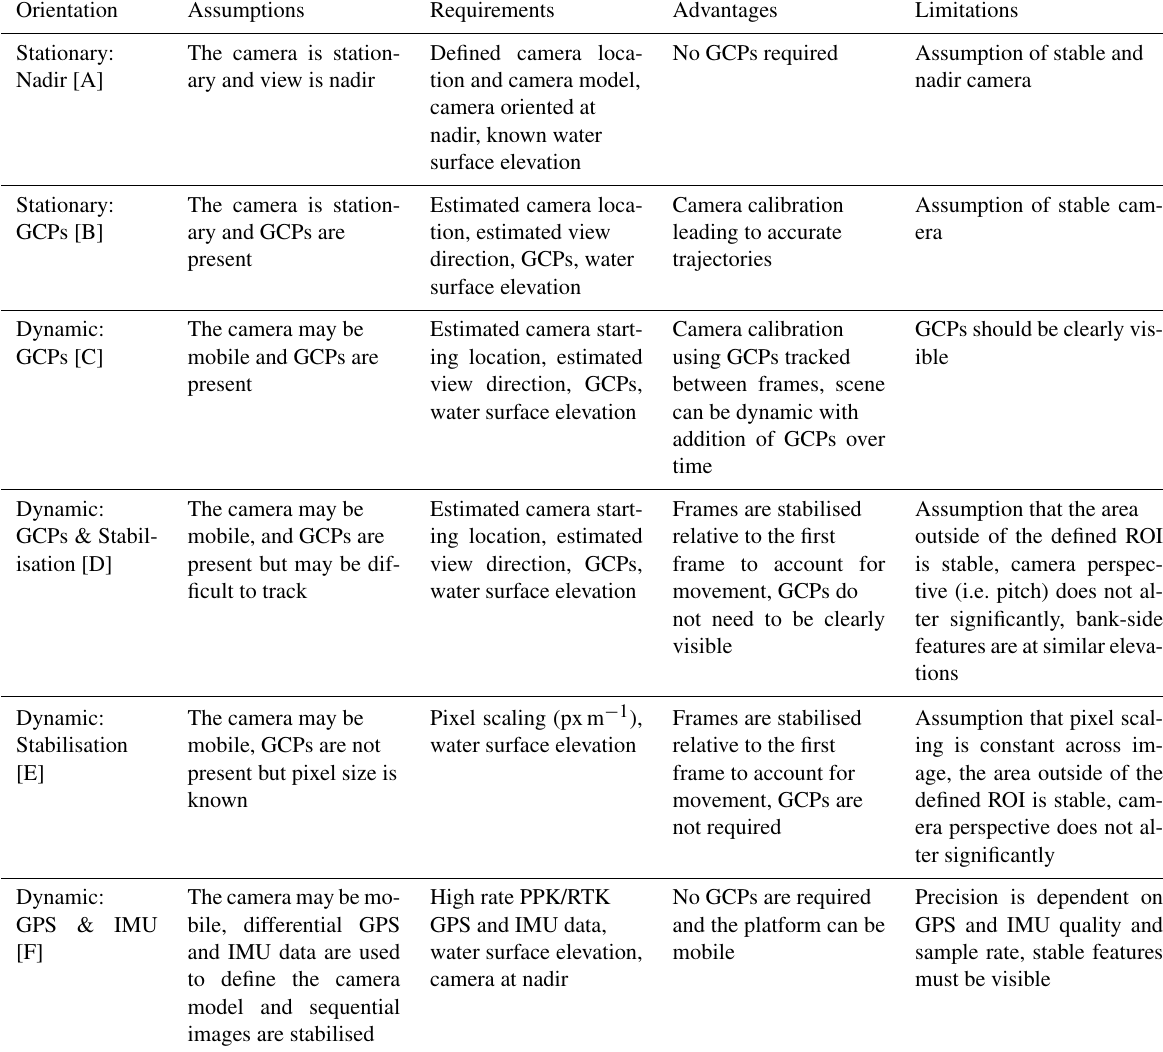
Table 1. A summary of the assumptions, requirements, advantages, and limitations of the different orientation options found with Section 1: video inputs of KLT-IV